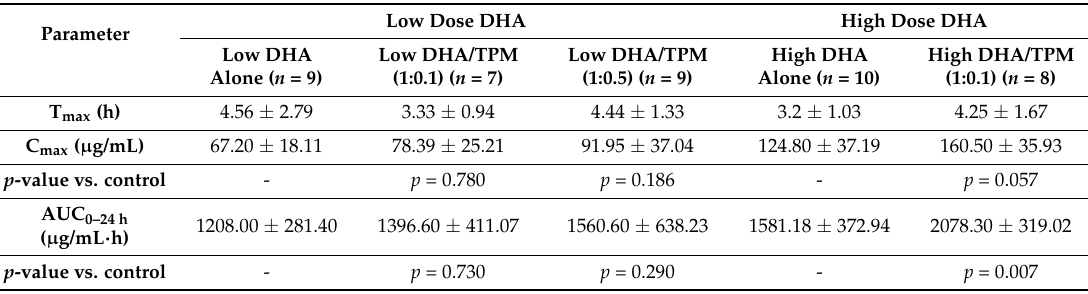
Table 2. Derived pharmacokinetic parameters for orally administered DHA in canola + TPM formulations (Data are mean ± SD n = 7–10). Blood samples were not collected from seven rats at all scheduled time points, (one from the Low DHA Alone, three from the Low DHA/TPM (1:0.1), one from the Low DHA/TPM (1:0.5) and two from the High DHA/TPM (1:0.5) groups) and